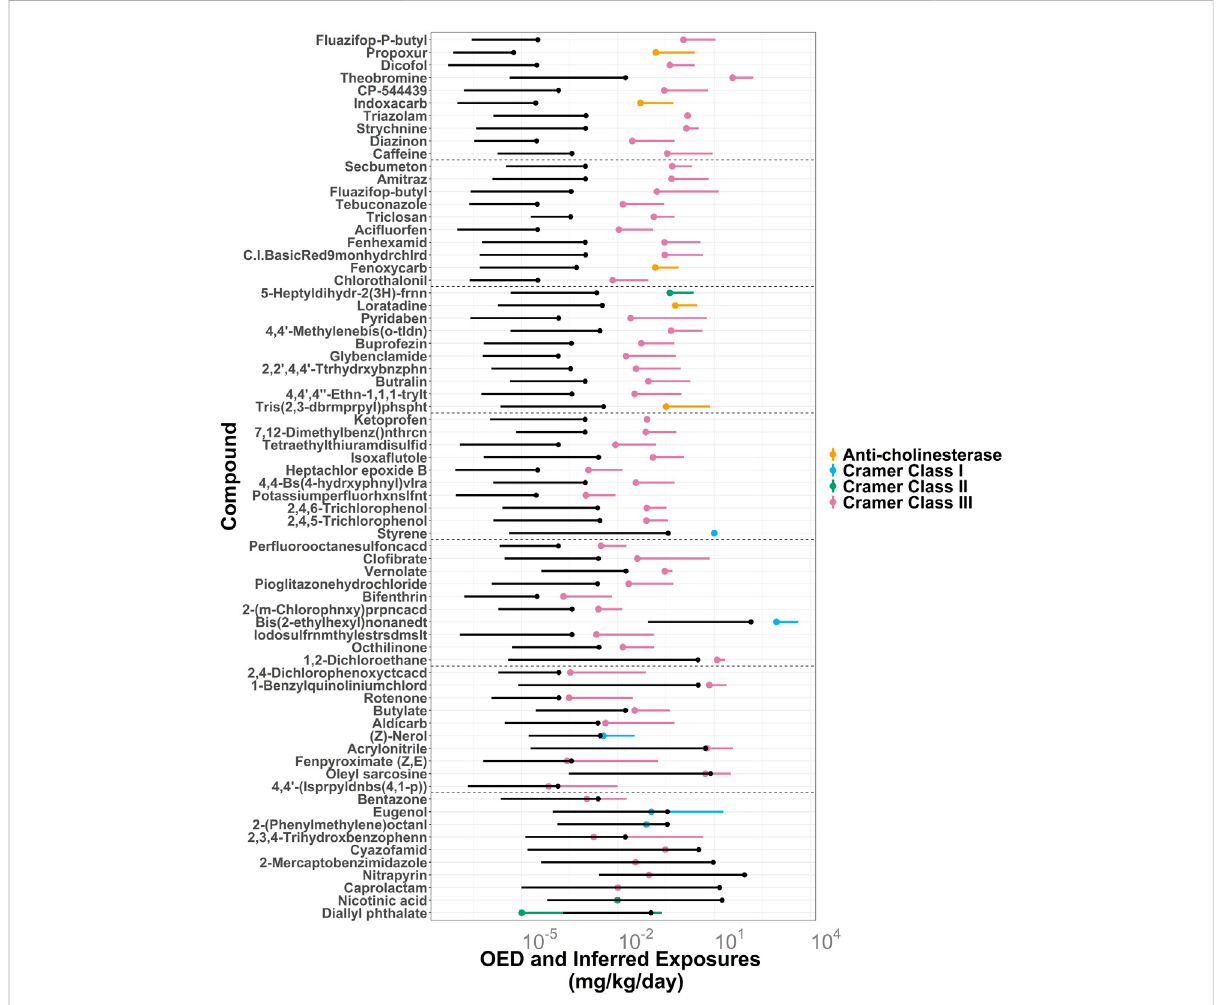
FIGURE 6 ExpoCast SEEM3 exposure estimates in black vs. oral equivalent doses (OEDs) for 70 ToxCast compounds with HT-IVIVE data grouped by the non-cancer TTC categories: Anti-cholinesterase, Cramer Class III, Cramer Class II, and Cramer Class I. The lower end of the OEDs are dots representing theOEDderived from the5thpercentile AC50values while theadjoining line segment extends up to theOEDderived from themedian AC50. Theupper endoftheexposures areblack dotsthat represent the95% con fi denceinterval for themedian exposure and thelowerlimit of theblacklinesegmentsrepresentthemedianexposureestimates.Theratioof5thpercentileOEDtothe95%CIformedianexposureincreasesfrom bottom to top. The fi rst 10 chemicals from each set of 100 are displayed, with dotted lines separating each set such that the fi rst chemicals are 1 – 10 (thelowestratio),thenextsetare101 – 110,etc.Forthisanalysis,the fi lterforGenotoxicitywasnotappliedfordeterminingtheTTCvalue,becausethe OEDs are not based genotoxicity or cancer